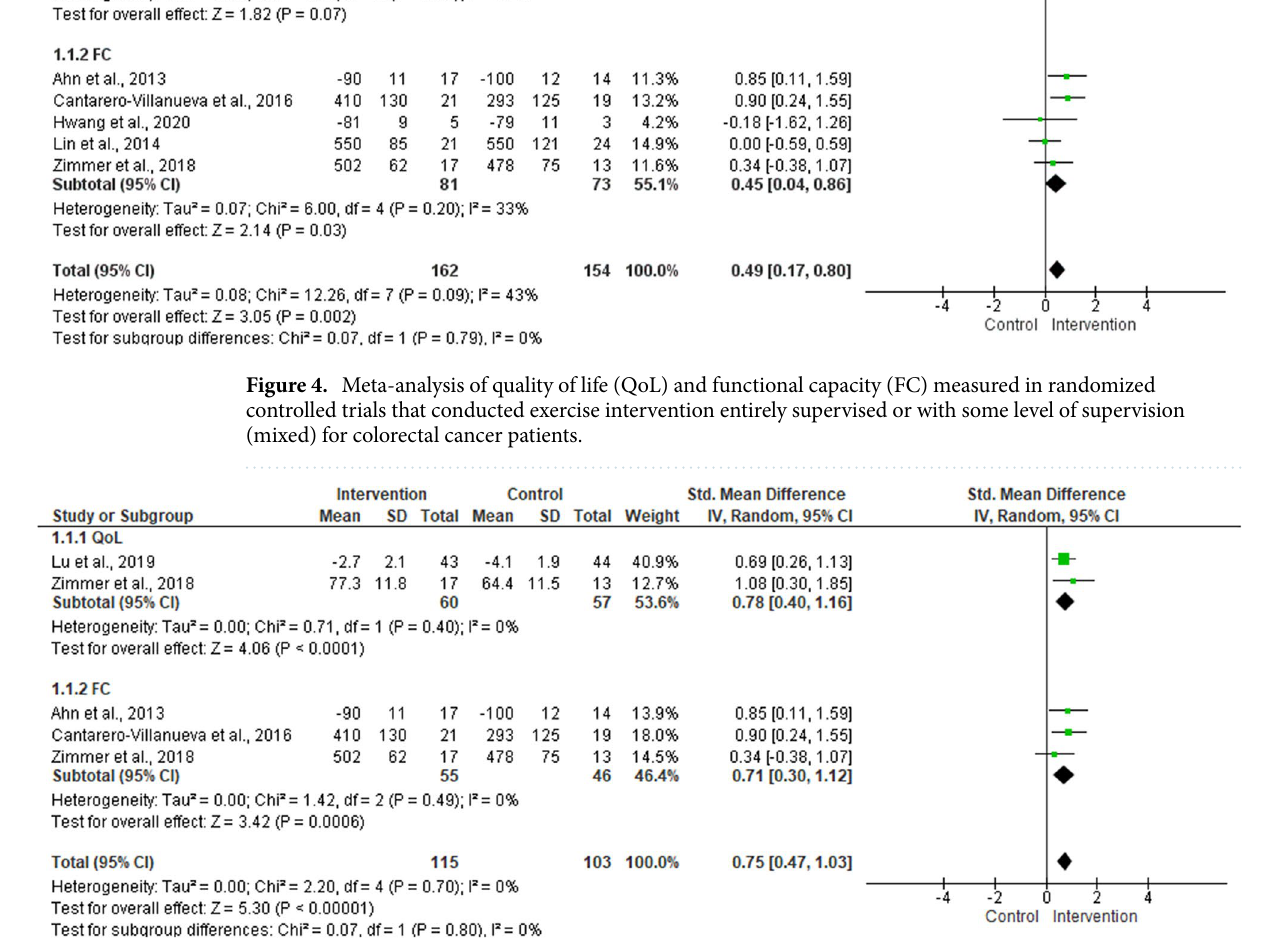
Figure 5. Meta-analysis of quality of life (QoL) and functional capacity (FC) measured in randomized controlled trials that conducted exercise intervention entirely supervised or with some level of supervision (mixed) with ≥ 80 of adherence for colorectal cancer